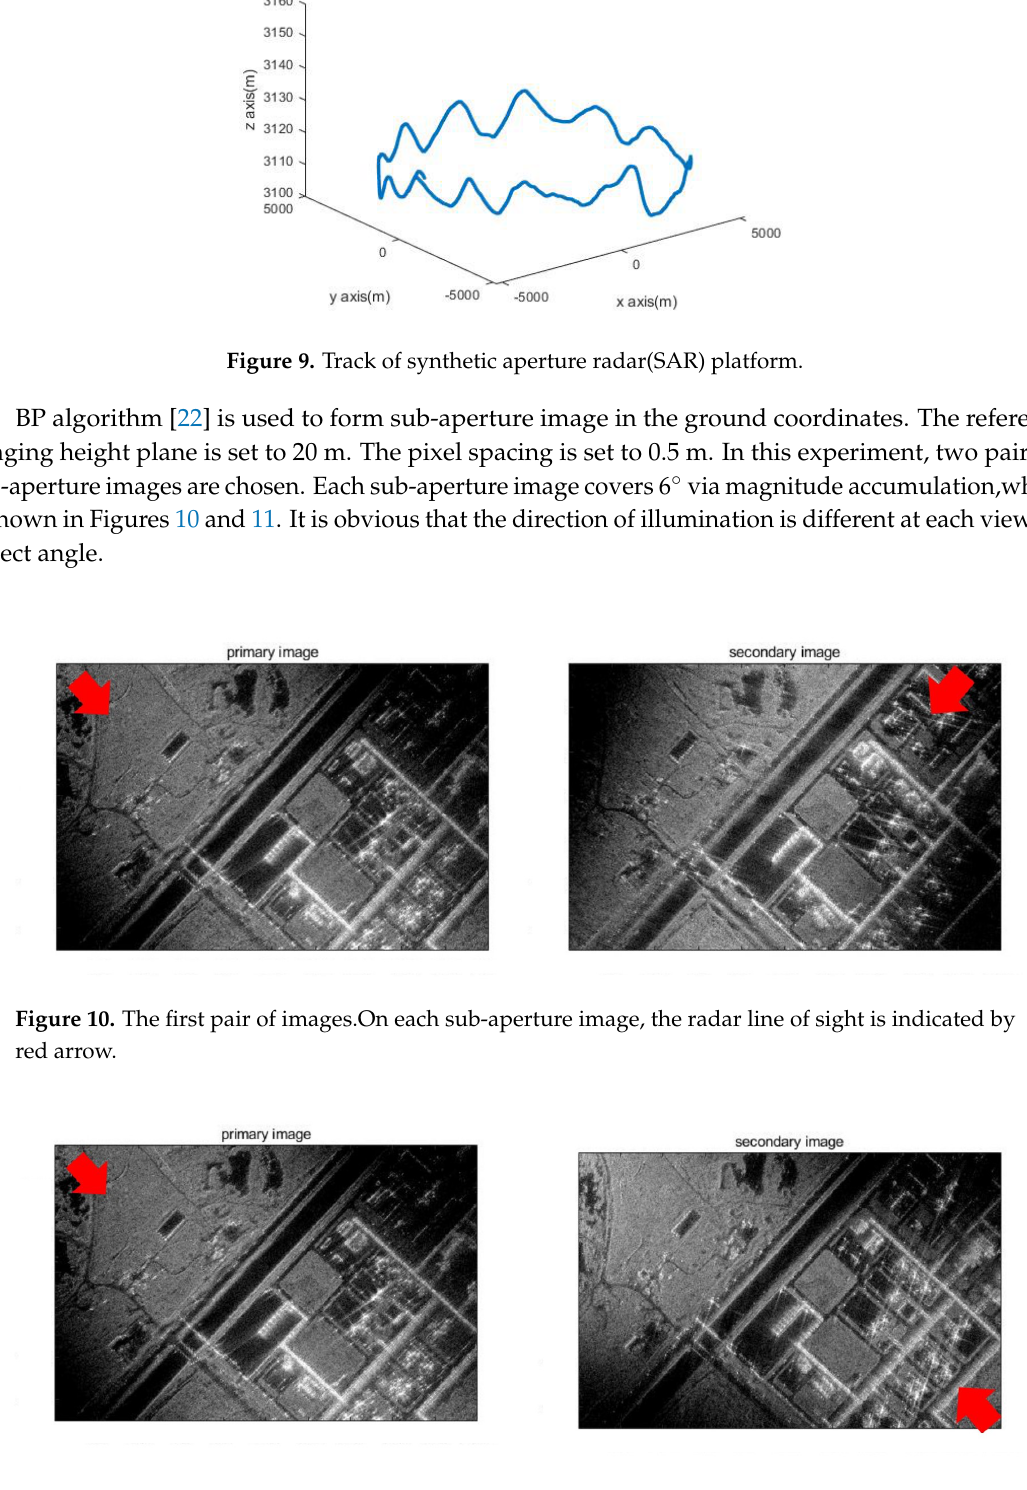
Figure 11. The second pair of images.On each sub-aperture image, the radar line of sight is indicated by red